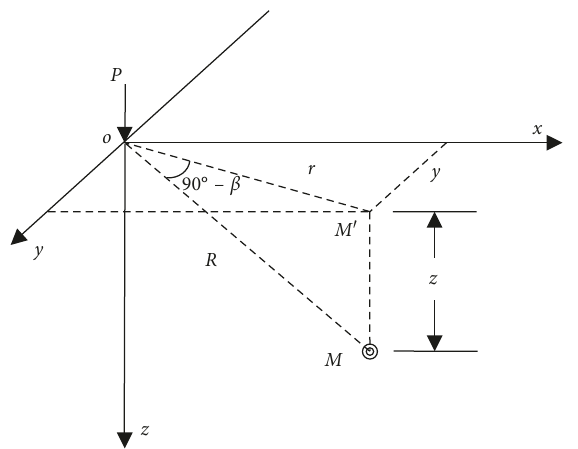
Figure 1: Diagram of Boussinesq’s